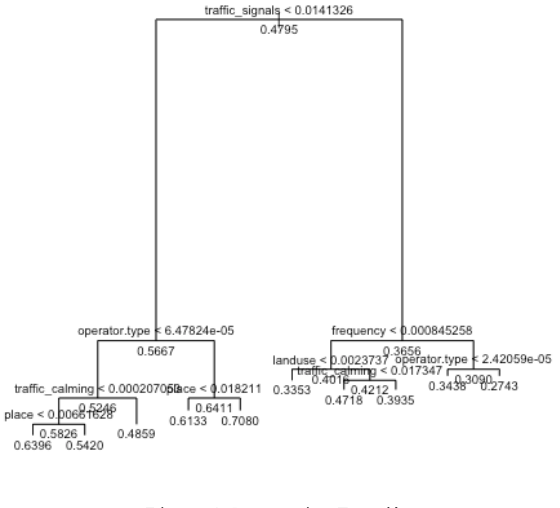
Figure 4. Regression Tree Keys